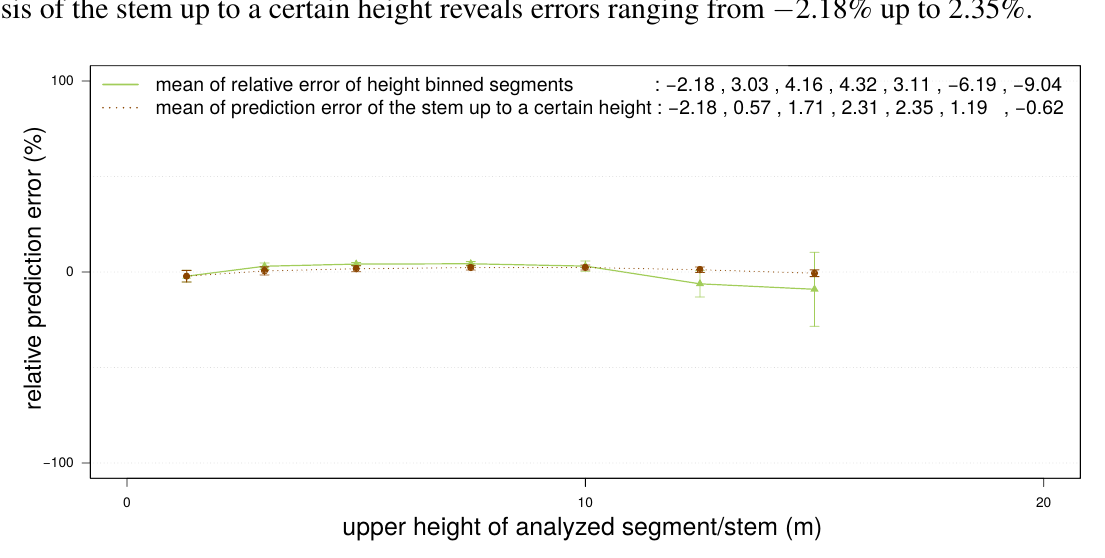
Figure 15. Prediction quality analyses of the stem of 12 P. massoniana . The green graph describes the averaged prediction error for all segments taken from the same height. The brown graph represents the prediction error of the cumulative volume of all stem segments up to a certain height. Both graphs include the standard error in form of error